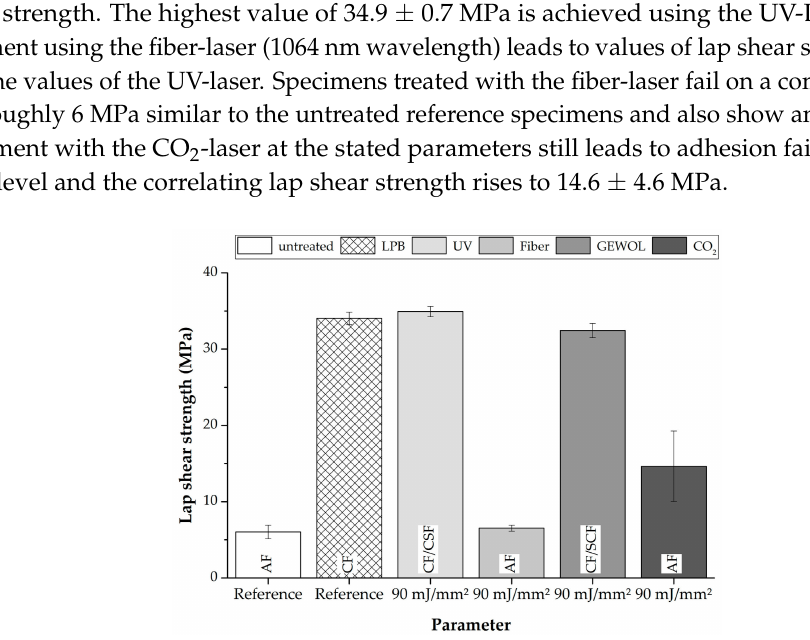
Figure 3. Comparison of the bonding performance of samples treated with different laser